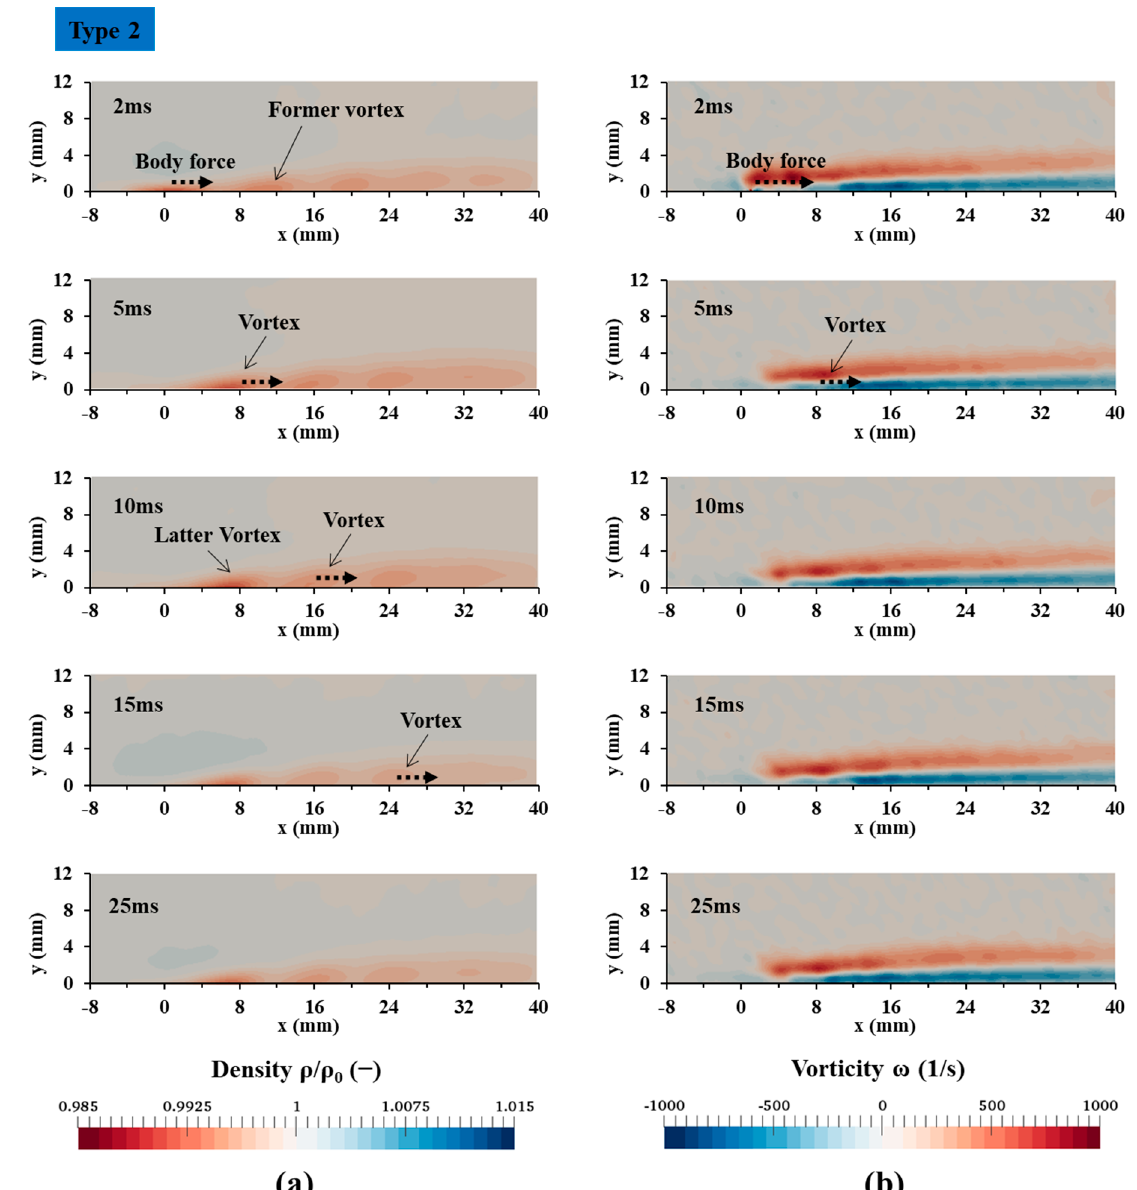
Figure 9. Time-series of ( a ) density field and ( b ) vorticity field contours in burst modulation at F = 7.2 kHz, BR = 40%, and T on = 2 ( f + = 200 Hz), 5, 10, 15, and 25 ms after turning on the burst signal input.